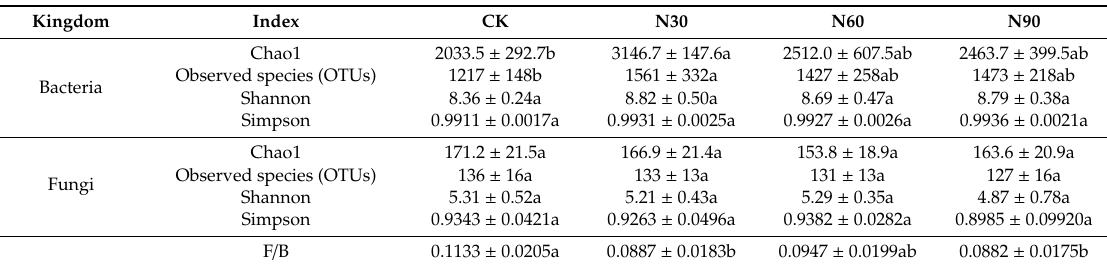
Table 2. Alpha diversity index of soil bacteria and fungi in the moso bamboo forest under di ff erent nitrogen addition levels. Values represent means ± SD ( n =